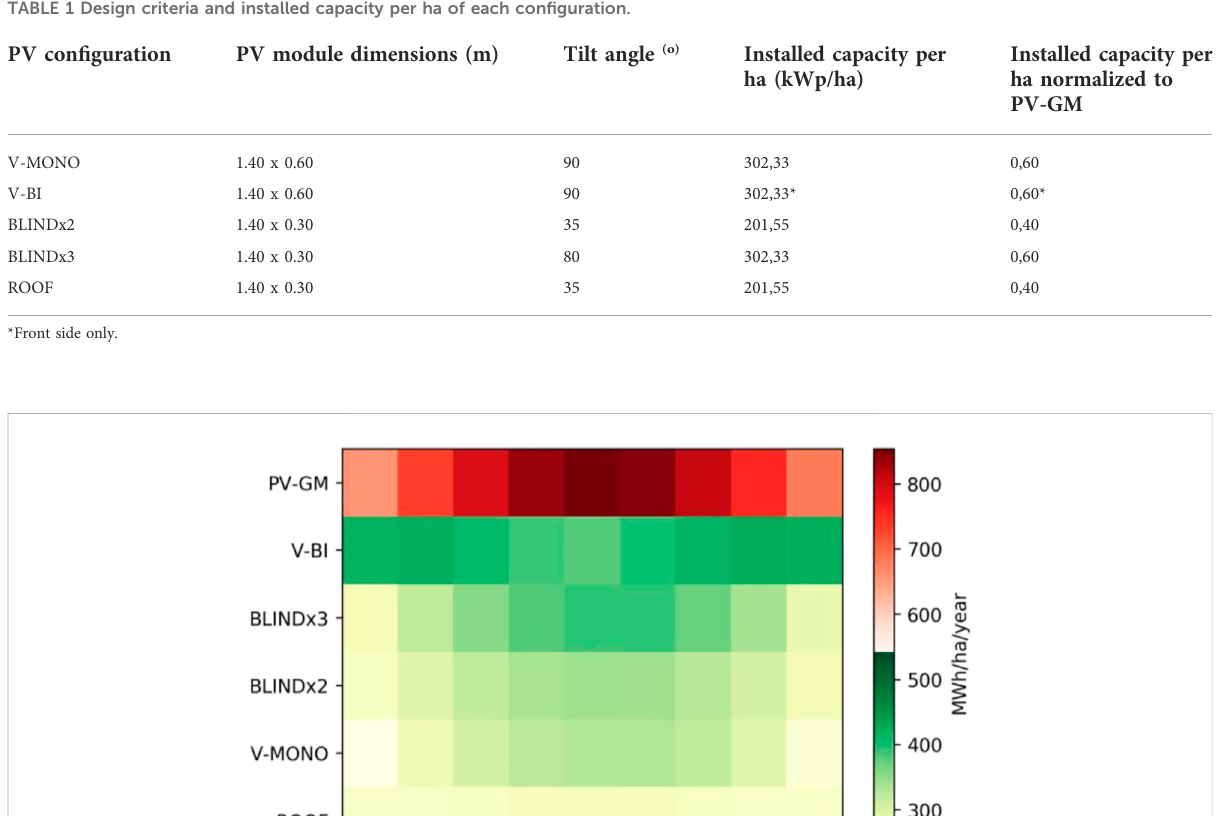
TABLE 1 Design criteria and installed capacity per ha of each con fi guration. PV con fi guration PV module dimensions (m)